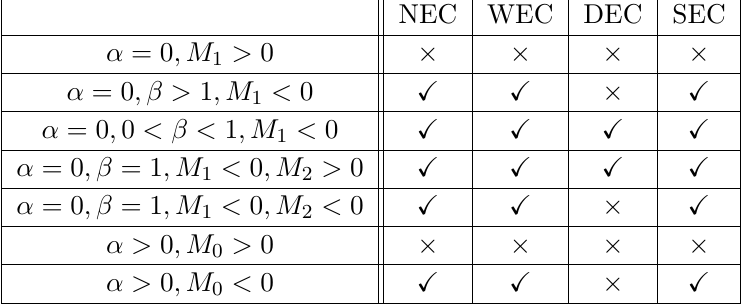
Table 2 . The energy conditions near r → ∞ in the spacetime (2.6) with eq.